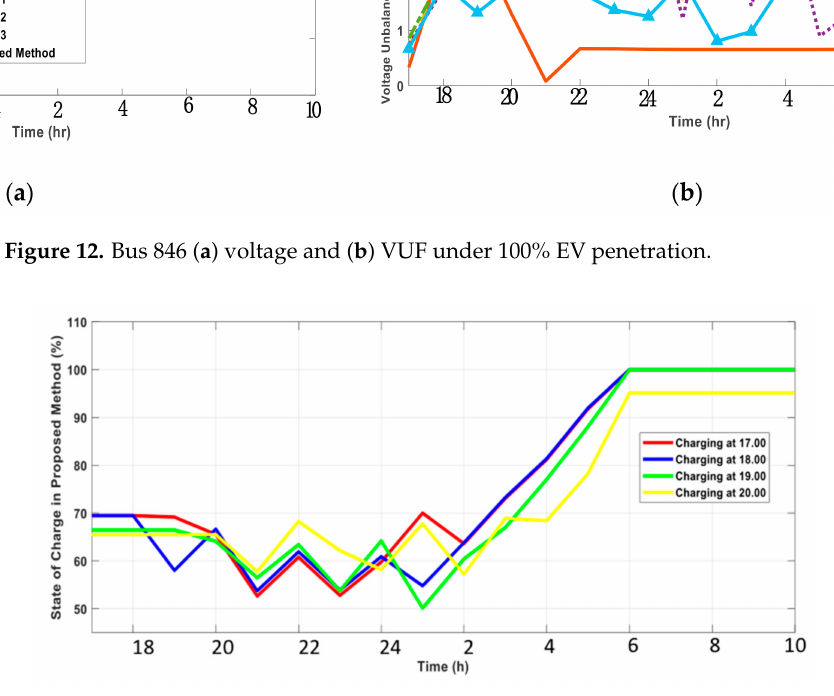
Figure 13. State of charge for the proposed